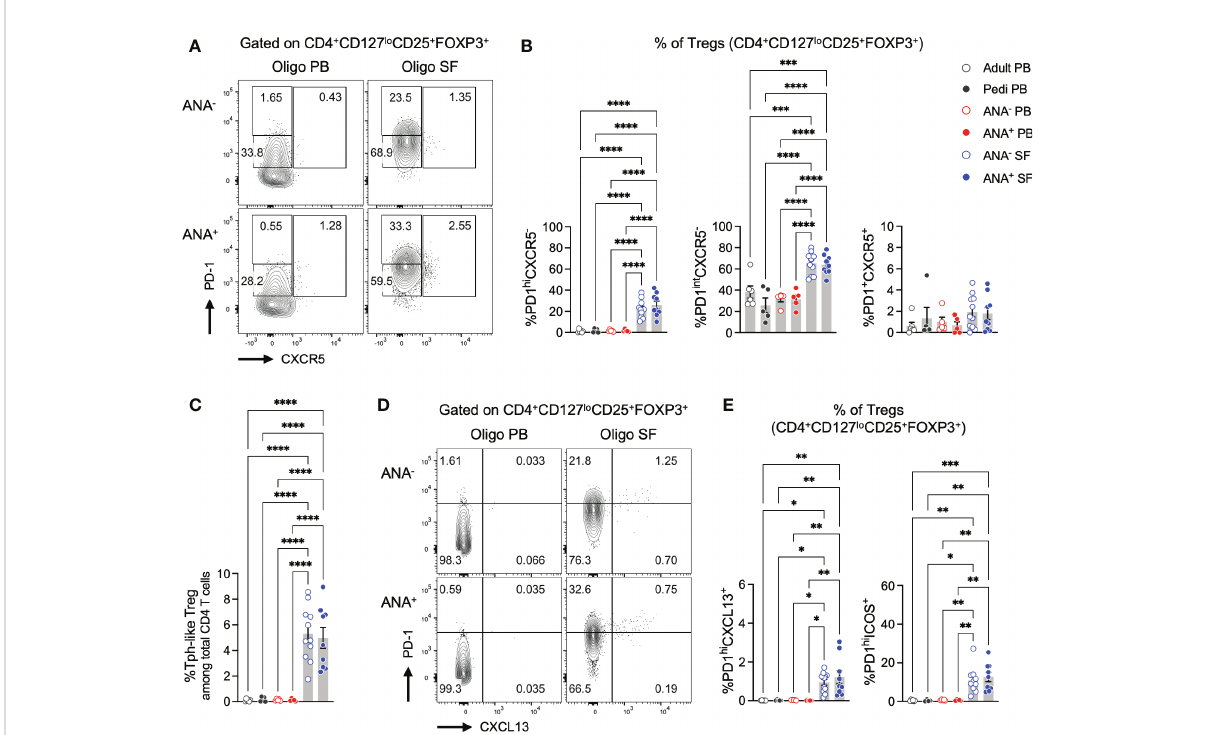
FIGURE 4 T regulatory cells expressing B cell help factors are enriched in oligo JIA synovial fl uid. (A) Representative fl ow staining of B cell helper CD4 + T cell populations in oligo JIA PB and SF, gated on Tregs (CD3 + CD4 + CD127 lo CD25 + FOXP3 + ). In each experiment, the PD-1 hi gate was set by evaluating unstimulated Treg cells from PB (often paired PB and SF sample from the same patient were used) and controls. This PD-1 hi gate was then applied to SF samples from oligo JIA patients evaluated during the same experiment. (B) Percent of Tph-like Treg (PD-1 hi CXCR5 - ), PD- 1 int CXCR5 + , and Tfr (PD-1 + CXCR5 + ) cells among Tregs in the SF of oligo JIA patients (ANA - : n=11, ANA + : n=9, blue circles), and in the PB of oligo JIA patients (ANA - : n=5, ANA + : n=5, red circles), and controls (pediatric: n=5, adult: n=6, black circles). (C) Percent of Tph-like Treg (CD4 + CD127 lo CD25 + FOXP3 + PD-1 hi CXCR5 - ) cells among total CD3 + CD4 + T cells. (D) Representative fl ow staining of PD-1 hi CXCL13 + T cells in oligo JIA PB and SF, gated on Tregs. (E) Percent of PD-1 hi CXCL13 + and PD-1 hi ICOS + cells among Tregs in the SF of oligo JIA patients (ANA - : n=10-11, ANA + : n=9), and in the PB of oligo JIA patients (ANA - : n=5, ANA + : n=5) and controls (pediatric: n=4-5, adult). Oligo JIA; oligoarticular juvenile idiopathic arthritis; PB, peripheral blood; SF, synovial fl uid; ANA, antinuclear antibody; pedi, pediatric; Tfr, T follicular regulatory